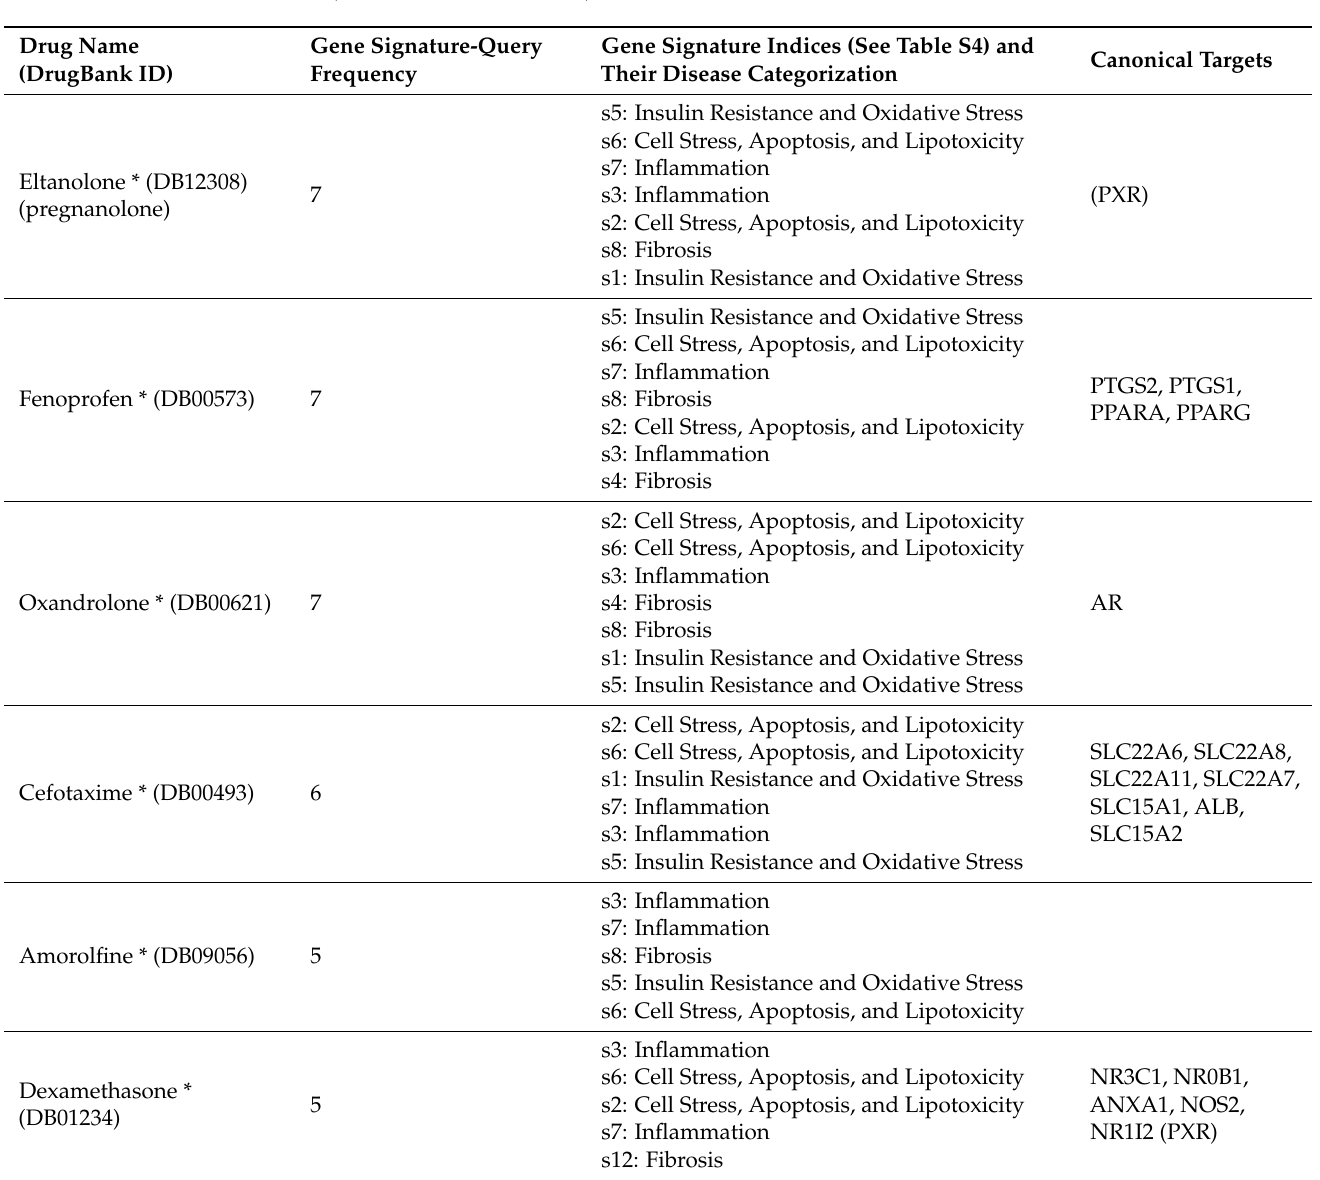
Table 1. The 25 highest ranked CMap-predicted drugs based on frequency of occurrence across multiple NAFLD-associated gene signature queries. Drugs/small molecules perturbagens identified in more than 1 of the 12 cluster-based gene signature queries were prioritized according to the number of occurrences across the 12 queries and termed: Gene signature-query frequency (Data File S4 and S5). Each signature-based query is indexed s1–12 (see Table S4 and Data file S3) and ordered (from highest to lowest) according to the relative rank of the drug within each query that the drug was identified (i.e., occurrence). Each gene signature-based query is associated with a predominant feature (i.e., disease category) of NAFLD (see Table S4; Data File S3, and Methods). The canonical targets derive from DrugBank (v5.1.4) except for (PXR) (explained in Results). Distinct from Table S5, CMap scores were calculated as percentile scores (see Methods, Results, and [20]), and the 2020 expanded LINCS Database was used as indicated in the Methods and Results. * Denotes compounds also found in a parallel top 25 CMap-predicted drug analysis using clinical classification-based signature queries (Table S4 and Data File